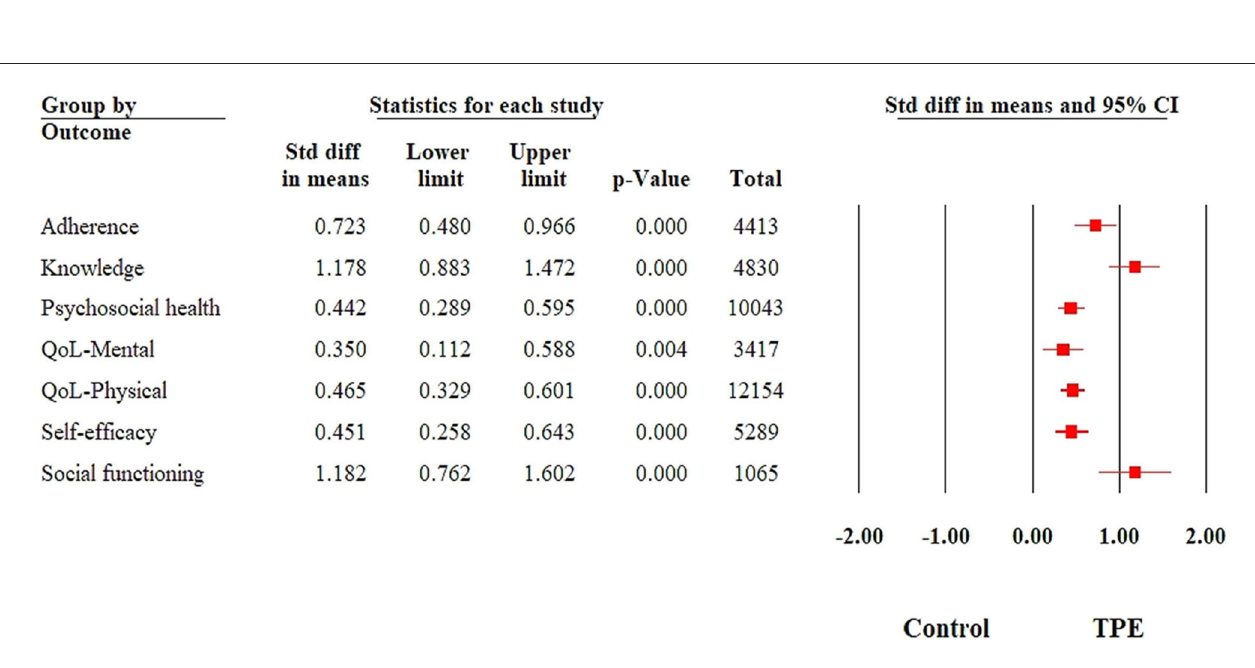
FIGURE6 Summary of a forest plot demonstrating the effectiveness of therapeutic patient education interventions among different psychosocial and psychological